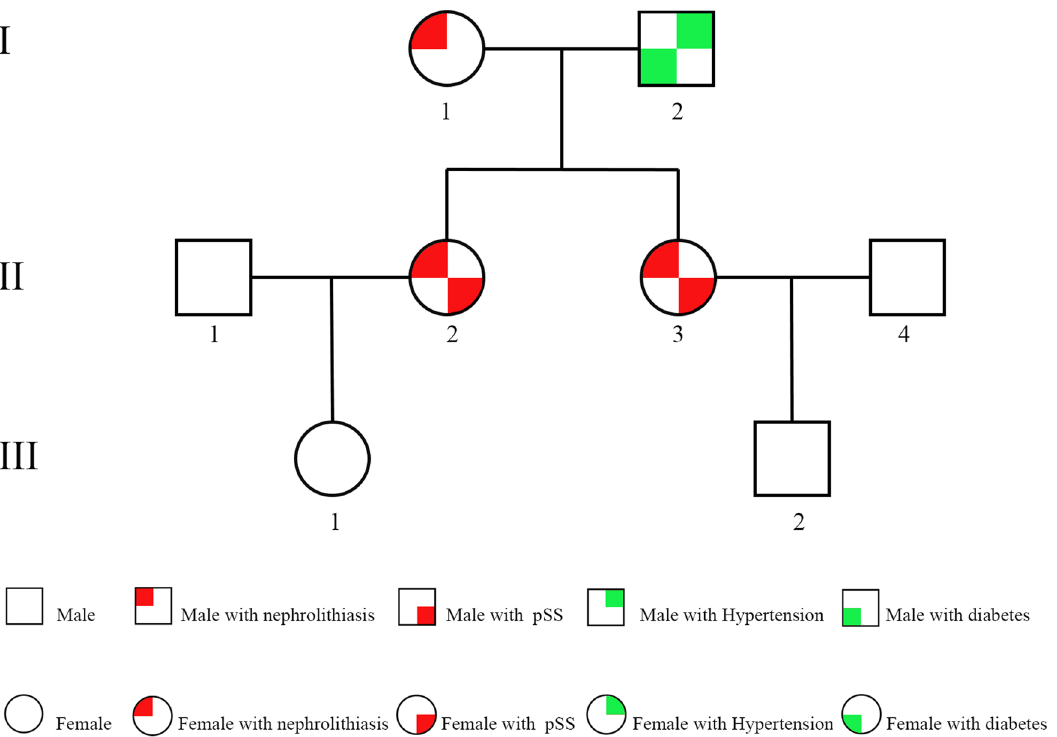
Figure 4: Family diagram. The patient ( 2 ) and her sister ( 3 ) were characterized by nephrolithiasis and primary Sjogren's syndrome while the mother ( 1 ) showed only the phenotype of nephrolithiasis. The rest members of the family are